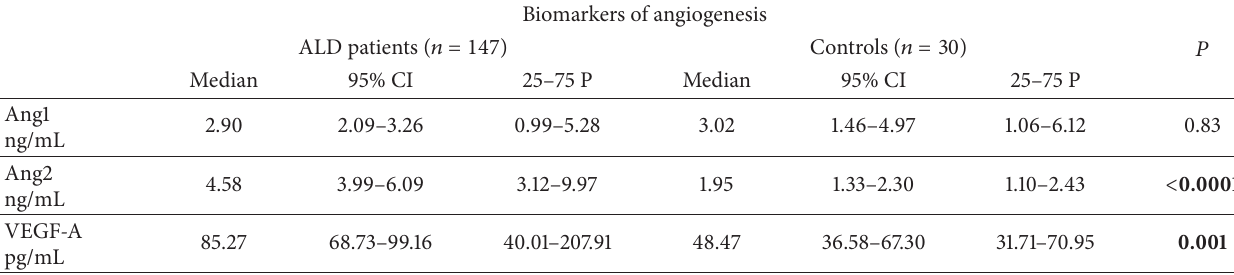
Table 2: Comparison of plasma angiogenesis-related biomarkers in ALD patients and the control group ∗ . Biomarkers of angiogenesis